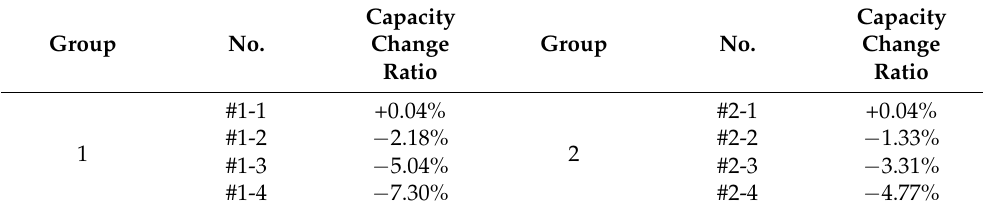
Table 3. Capacity change ratio of low-temperature